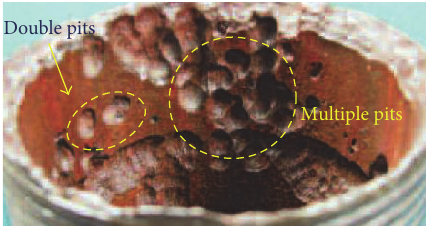
Figure 1: Typical pitting corrosion in tubing inner surface.